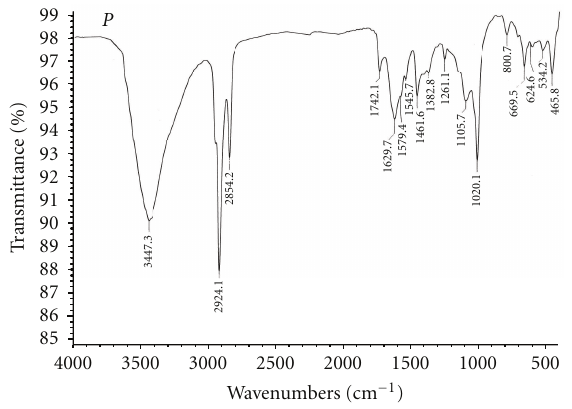
Figure 5: FT IR spectrum of scrapped compound.